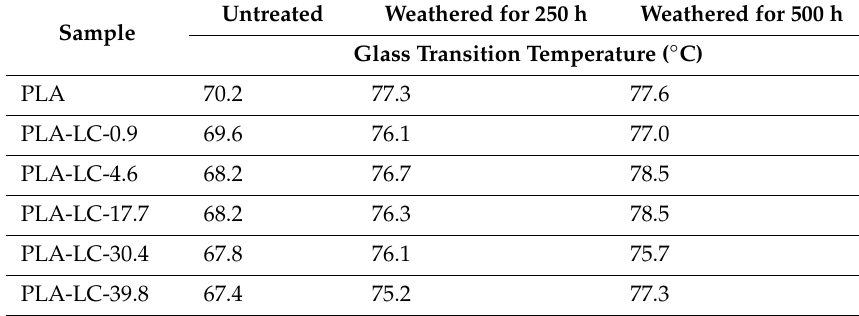
Figure 6. The run of storage modulus ( G (cid:48) ) versus temperature, loss modulus ( G ”) versus temperature and damping factor (tan δ ) versus temperature curves for the composite samples weathered for di ff erent periods of time. Table 3. Glass transition temperatures (understood as tan δ maximum) for pure PLA and composite samples weathered for di ff erent periods of